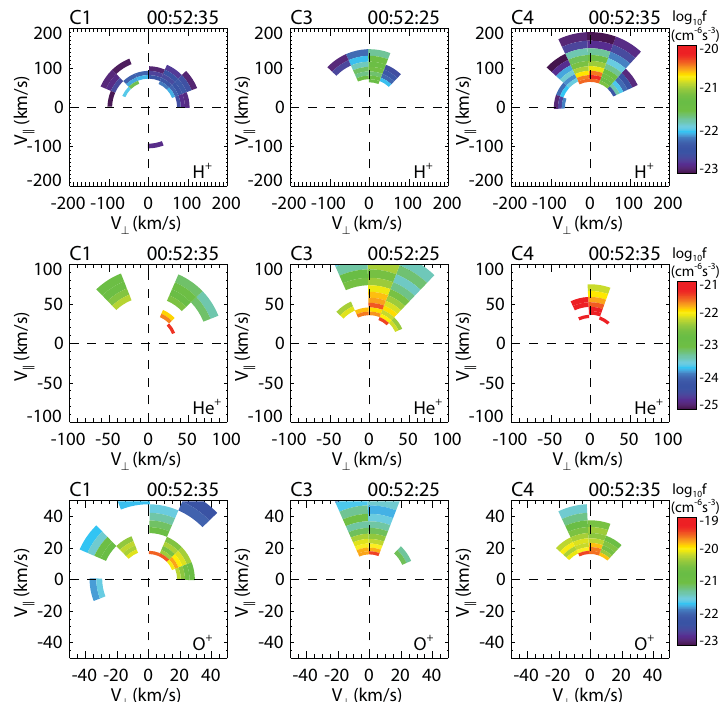
Figure 3. Four types of field-aligned velocity distributions observed by Cluster. These are the 2-D cuts of the 3-D distributions obtained with spin-time resolutions of 4s. The top row shows H + distribution, the middle row He + , and the bottom row O + . The three columns are observations from Cluster 1, 3, and 4. Four types of beams (beams with narrow velocity range; a more complex distribution with larger velocity range; multiple discrete beams each with different velocity; and beams off the magnetic field axis, possibly ion conics) are observed for all ion species and all Cluster spacecraft. Note that the velocity scales of the plots are